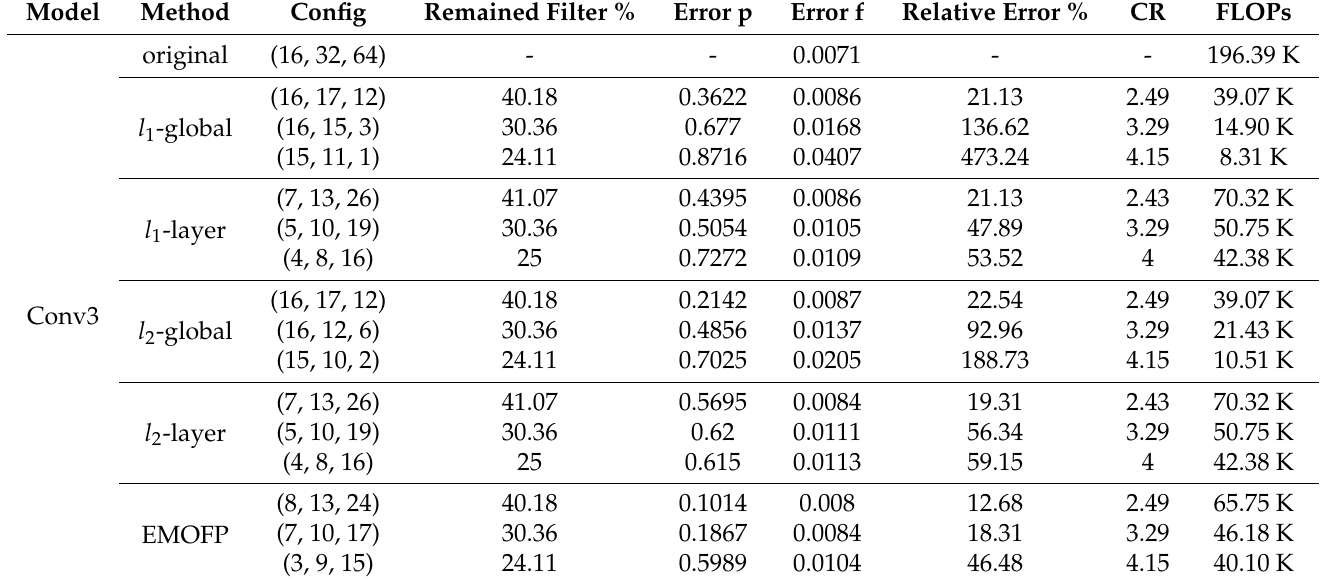
Table 5. Pruning results of Conv3 on